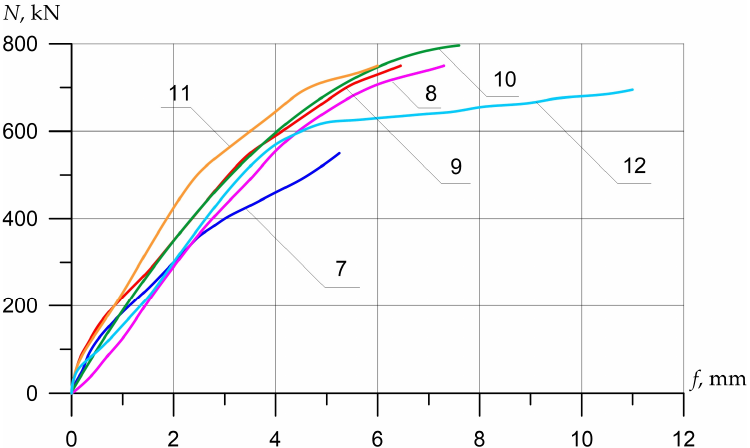
Figure 13. Comparison of experimental values of column deflections ( λ h = 10) depending on the magnitude of the load and variants for composite reinforcement with axial eccentricity e 0 = 2.0 cm (0.16 h). The numbers on the graphs correspond to the column numbers in Table 4.